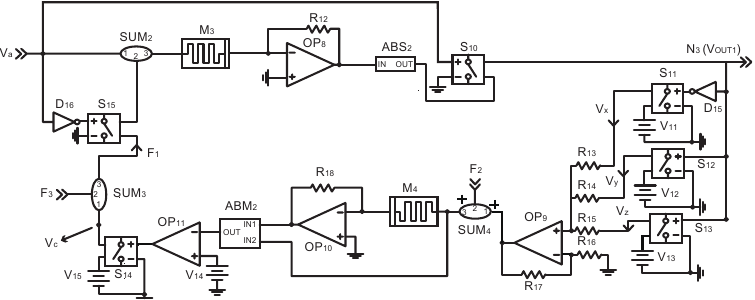
Figure 6. Habituation module. F 1 , F 2 and F 3 are feedback signals. S 11 , S 12 , S 13 , S 14 , S 15 and S 10 are the voltage-controlled switches. V 11 = − 0.1 V, V 12 = 4 V, V 13 = − 6.5 V, V 14 = 0.2 V, V 15 = − 1 V. The closed voltage of S 14 and S 15 is 2 V. The closed voltage of S 11 and S 12 is 1 V. The closed voltage of S 10 is 0.9 V. The closed voltage of S 13 is 2.1 V. R 12 = 1 k Ω , R 18 = 100 Ω , R 13 = R 14 = R 15 = R 17 = 20 k Ω , R 16 = 10 k Ω